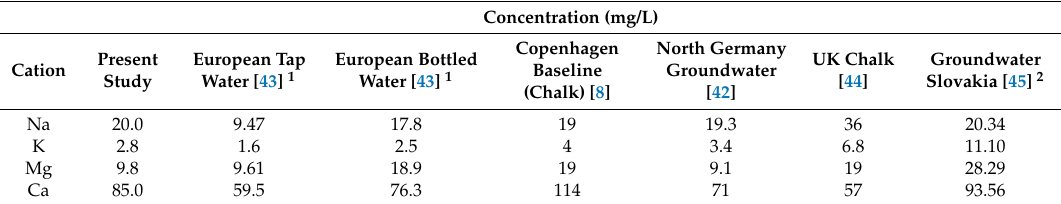
Table 5. Median concentration (mg/L) of the four cations in the present study in comparison to other